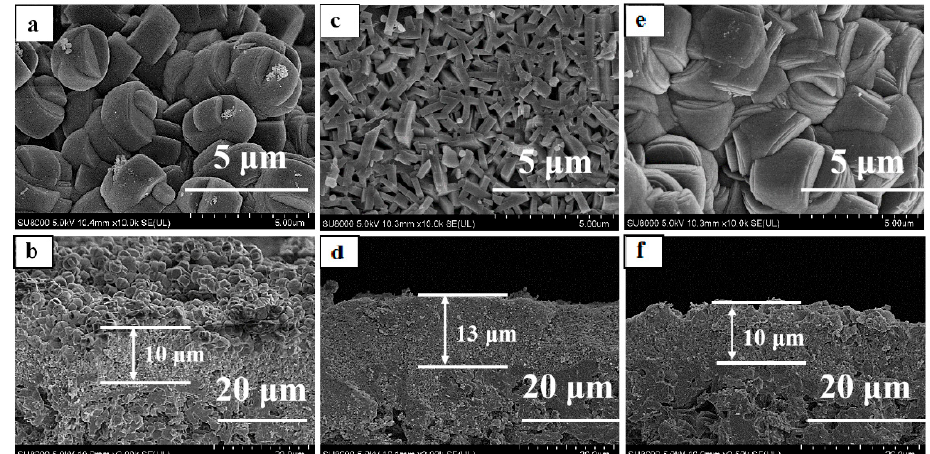
Figure 6. Surface and cross-section SEM images for TS-1 zeolite membranes with different morphology of seeded crystals. ( a , b ) M-4; ( c , d ) M-5; ( e , f ) M-6.